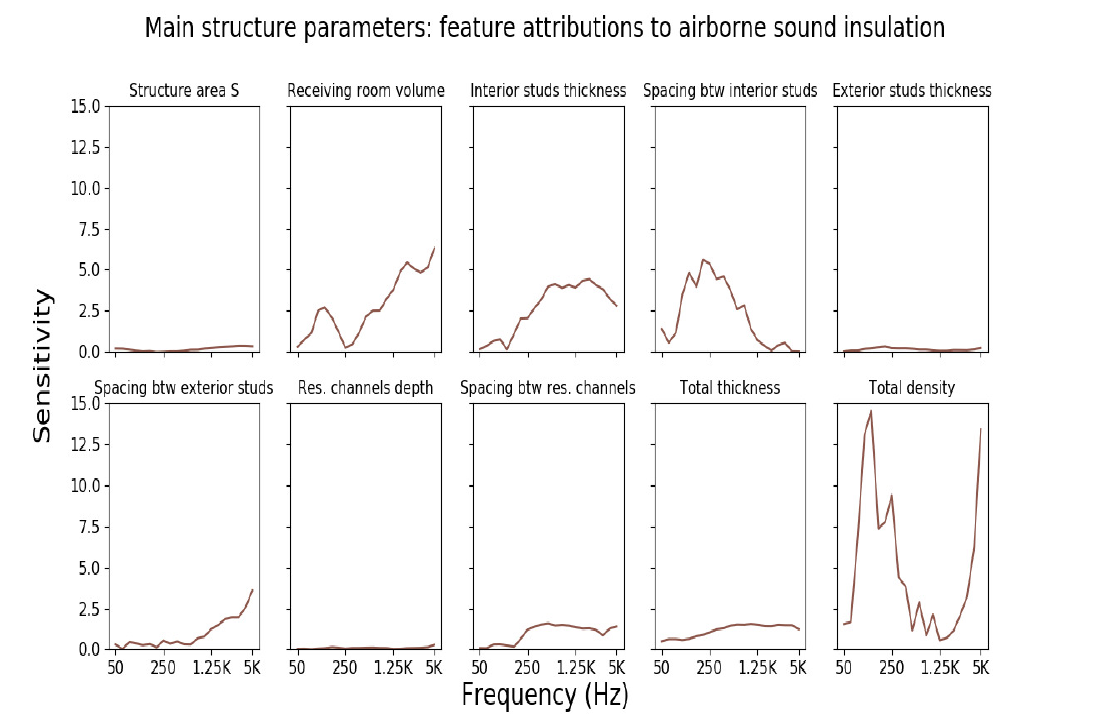
Figure 7. Attributions analysis of additional variables to the prediction of airborne insulation